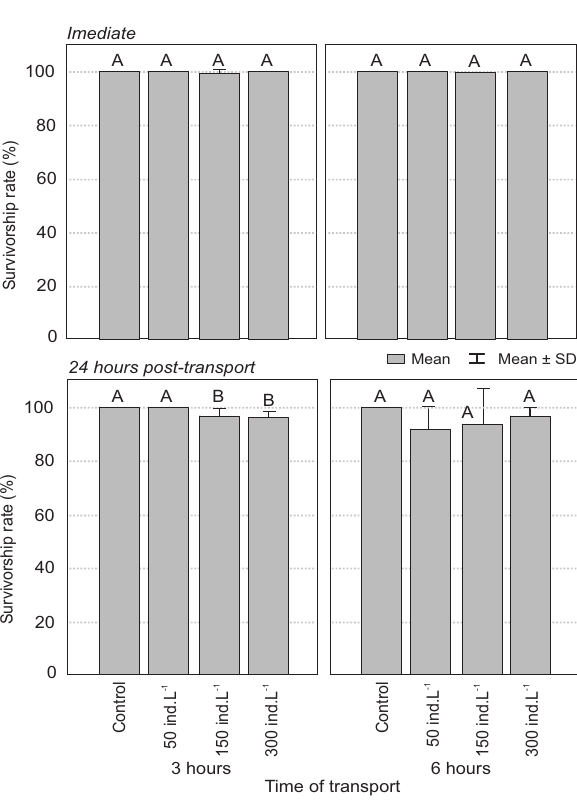
Figure 1. Survivorship rates of U. cordatus megalopae submitted to transport simulations at different loading densities and dura- tions, immediately and after 24 hours of simulation. Letters over bars indicate homogeneous groups according to Fisher LSD Test with a 5%